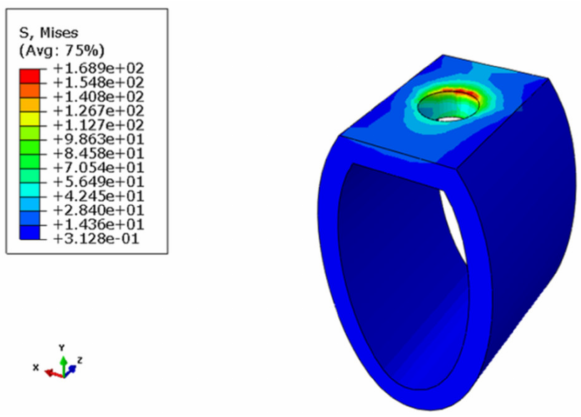
Figure 10. Stress distribution in the cortical bone.